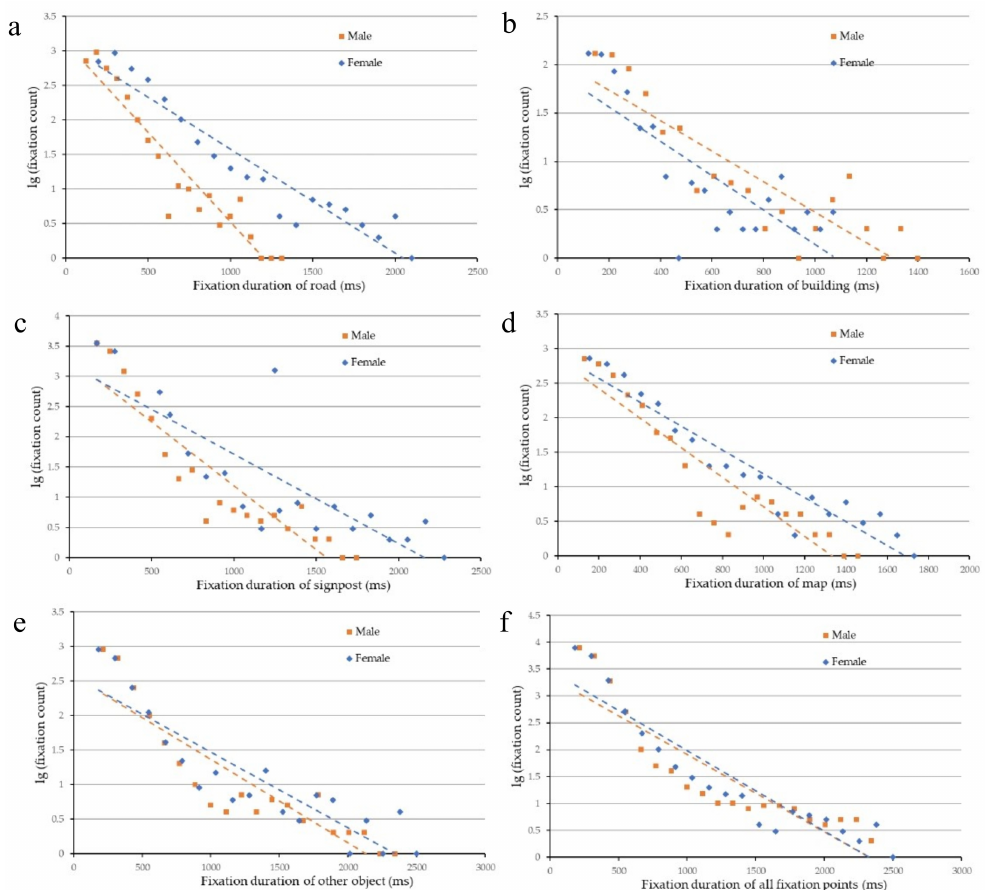
Figure 6. The fitness of the fixation durations for di ff erent areas of interest (AOIs; ( a )–( e )) and the total fixation distribution ( f ) between males and